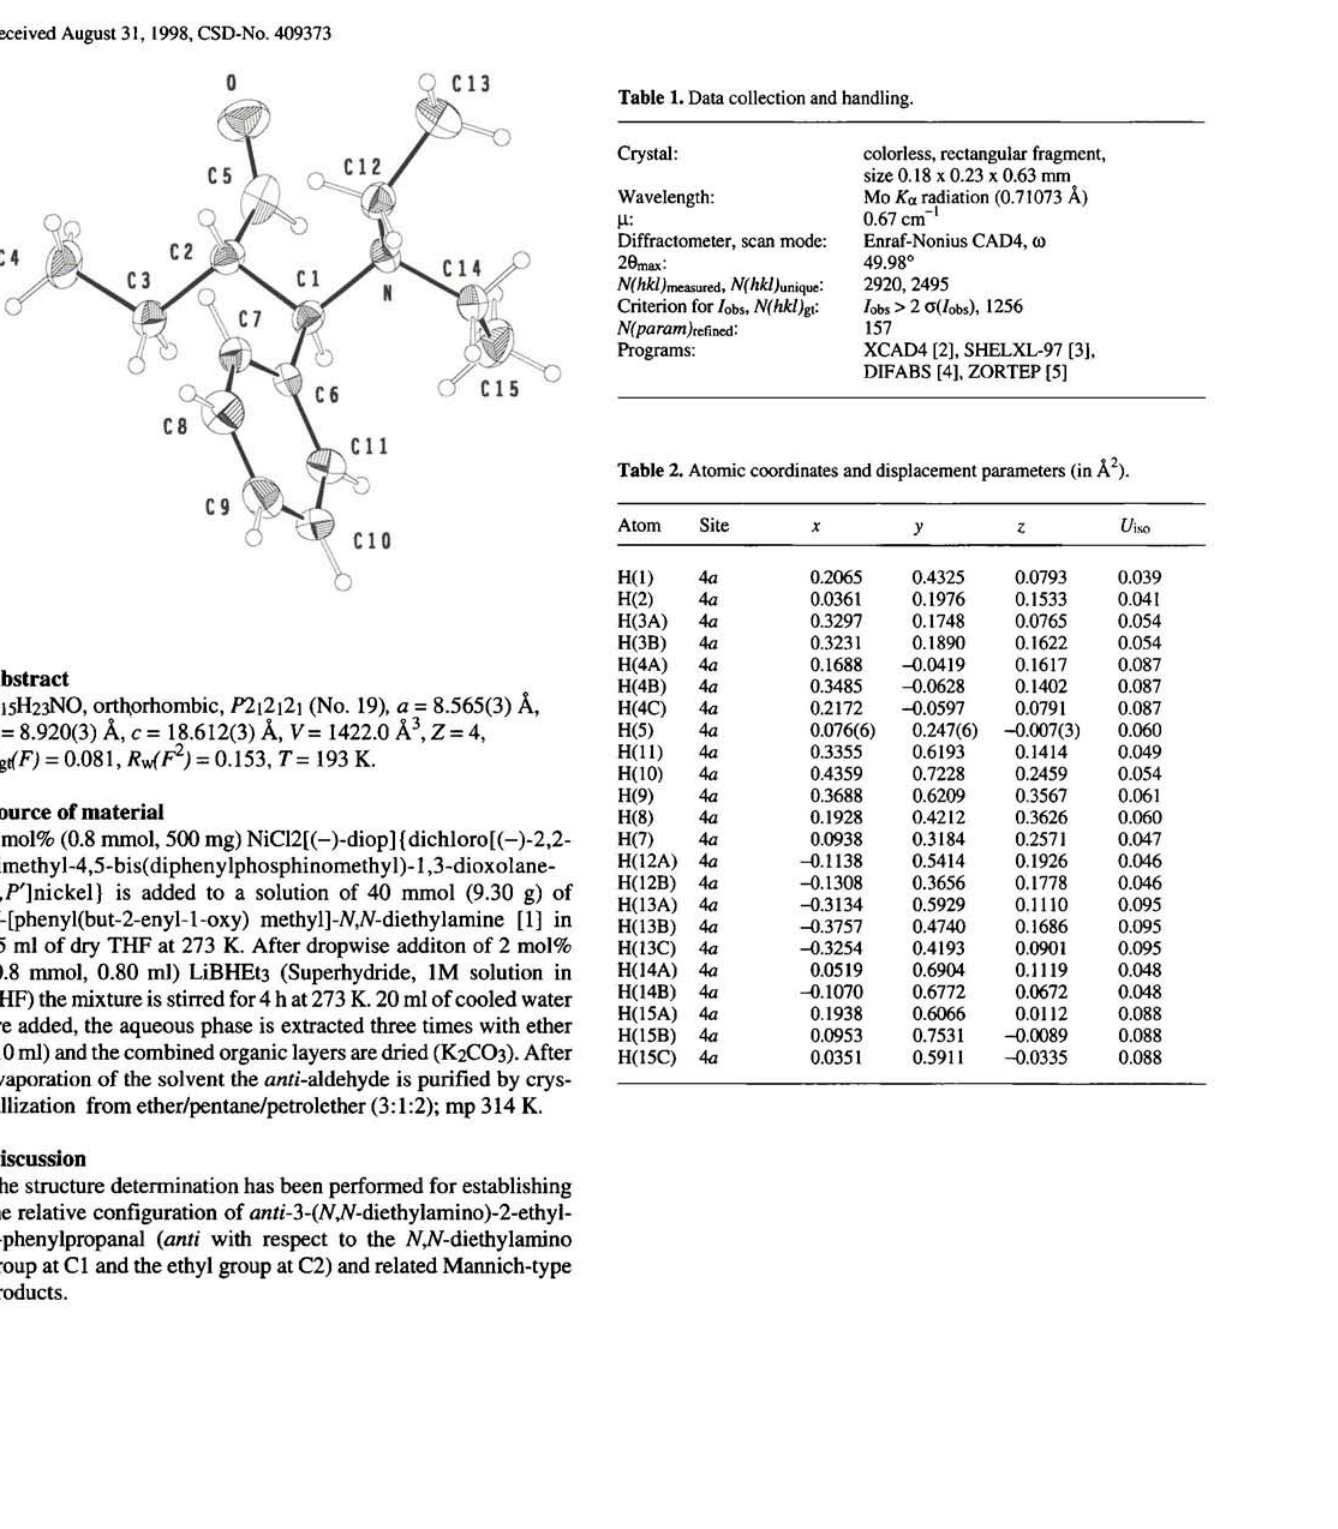
Table 1. Data collection and handling.